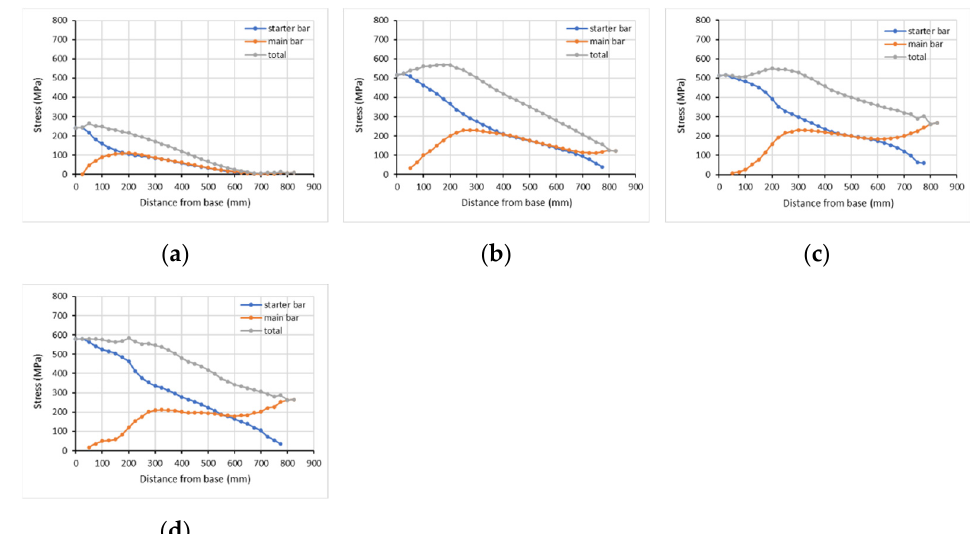
Figure 11. Developed stress along starter longitudinal bars in tension at a displacement of ( a ) 3.39 mm, ( b ) 9.74 mm ( δ y ), ( c ) 23.88 mm ( δ Pmax ) and ( d ) 36.86 mm ( δ u ), for column R-0L0.